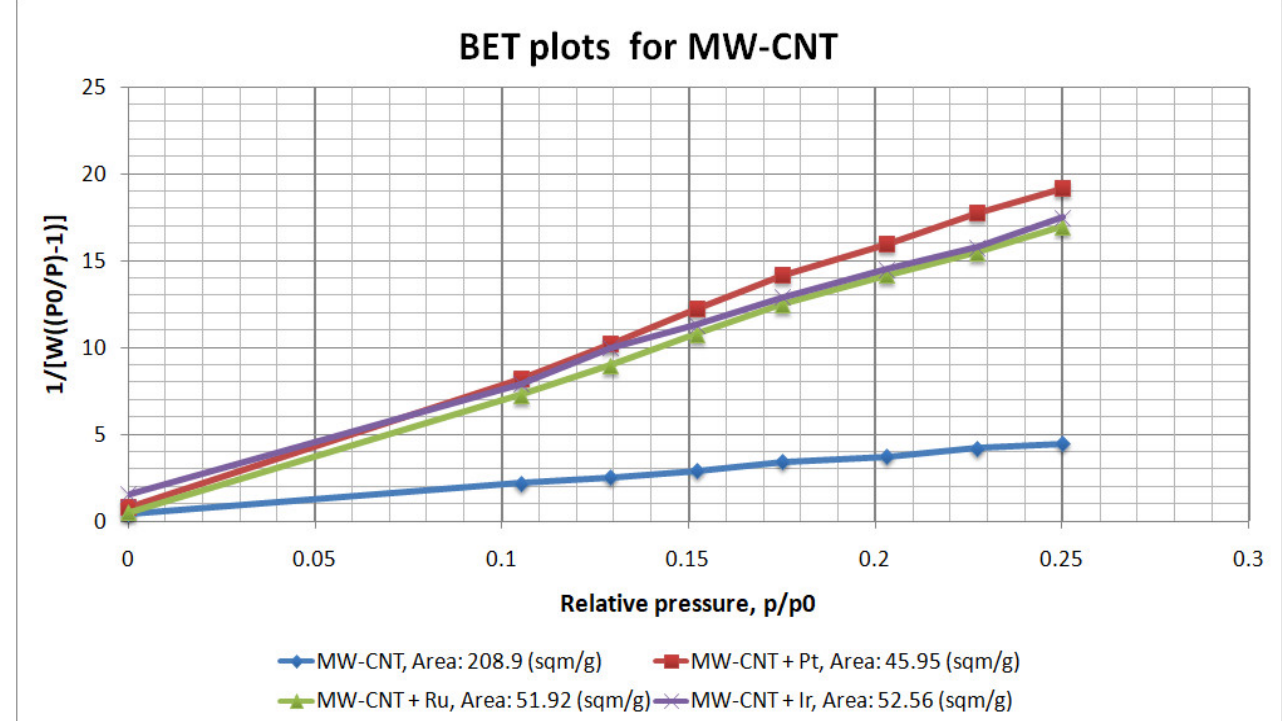
Figure 3. BET plots for the doped and undoped MW-CNTs.